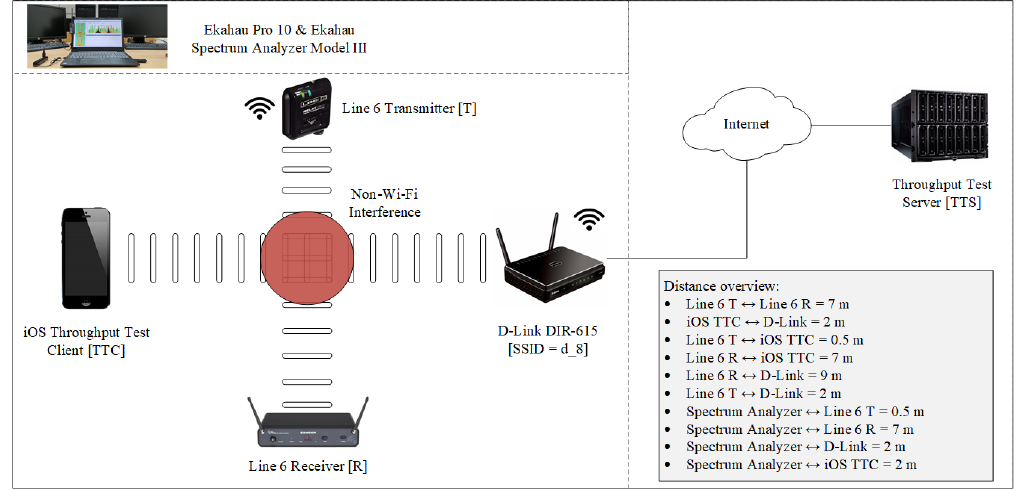
Figure 5. Network architecture settings for analyzing the effects of non-IEEE 802.11 interference on throughput of a wireless network under laboratory conditions.